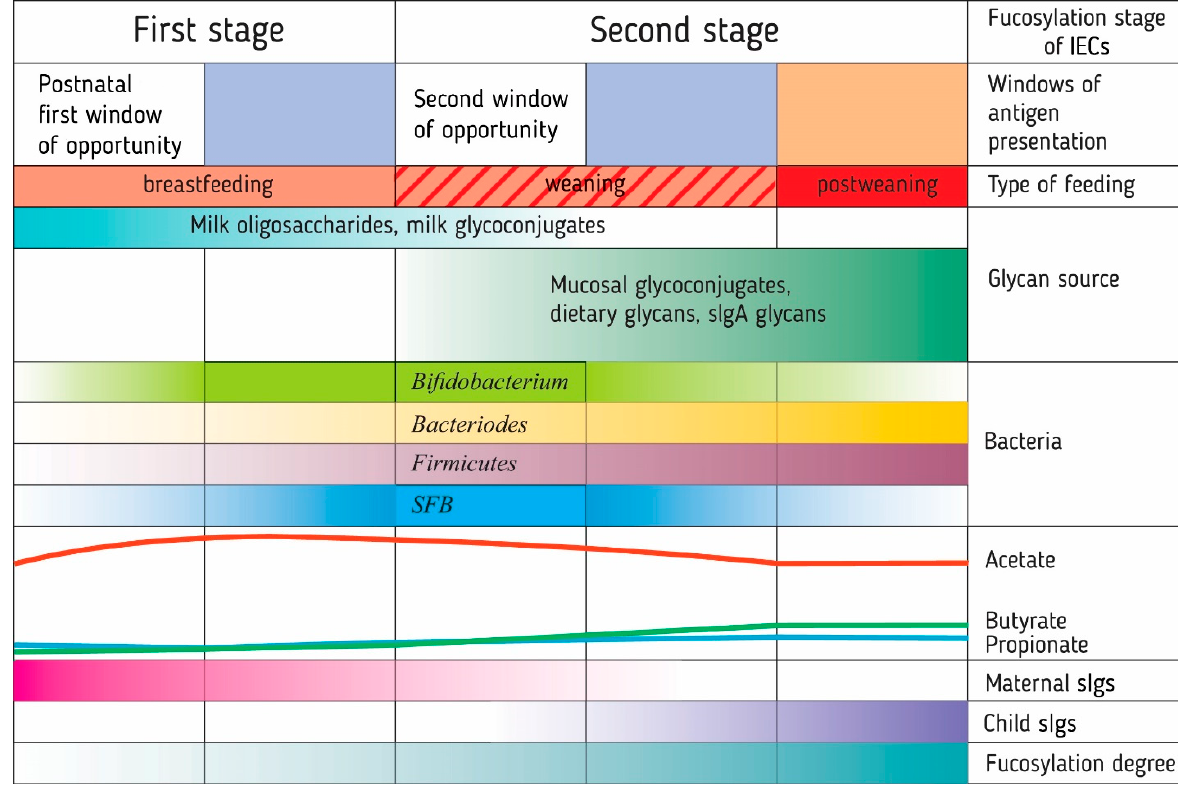
Figure 2. The formation of a ‘layered’ immunity in an infant through a number of sequential processes associated with fucosylation. These processes have several critical time periods, called windows of opportunity, during which the immune system is trained by antigens presented to it. The presentation of fucosylated patterns of food (oligosaccharides and glycoconjugates of breast milk) and bacterial antigens ( Bacteroides ) for the development of immune tolerance to them probably occurs before the opening of the second window of opportunity in the development of the immune system during breastfeeding. The synthesis of carbohydrate patterns in bacteria is determined by the type of glycans available for metabolism by intestinal bacteria. The introduction of solid foods in infancy opens a second window of opportunity due to the presentation of new food and bacterial antigens. Glycan-degrading Bacteroides stimulate the growth of Firmicutes and butyrate production, which, along with segmented filamentous bacteria (SFB), enhances the fucosylation of the intestinal epithelial glycocalyx. Human breast milk, mucin, and secretory immunoglobulin glycans are part of the host’s mechanism controlling bacterial colonization. IECs: intestinal epithelial cells. sIgs: secretory immunoglobulins.